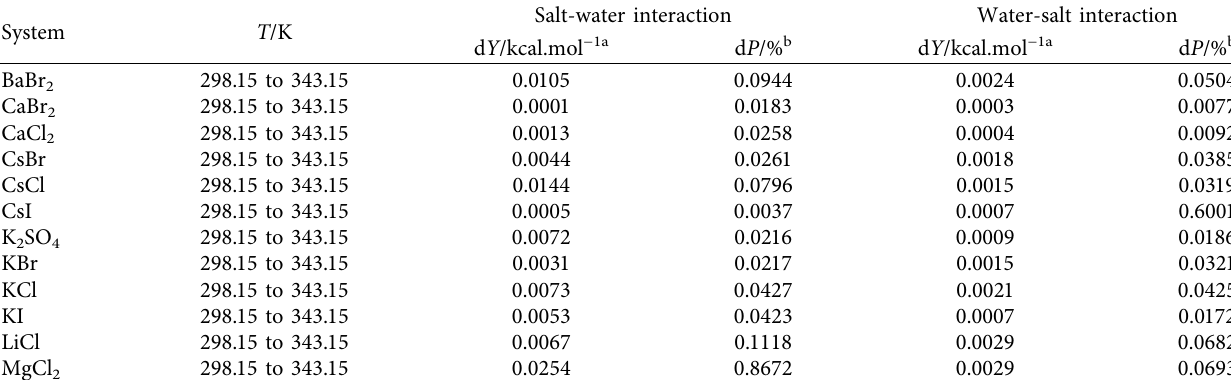
2 O system. (a) The interaction of LiCl and (b) the interaction of H 2 O. Symbols Table 7: Correlation of H int